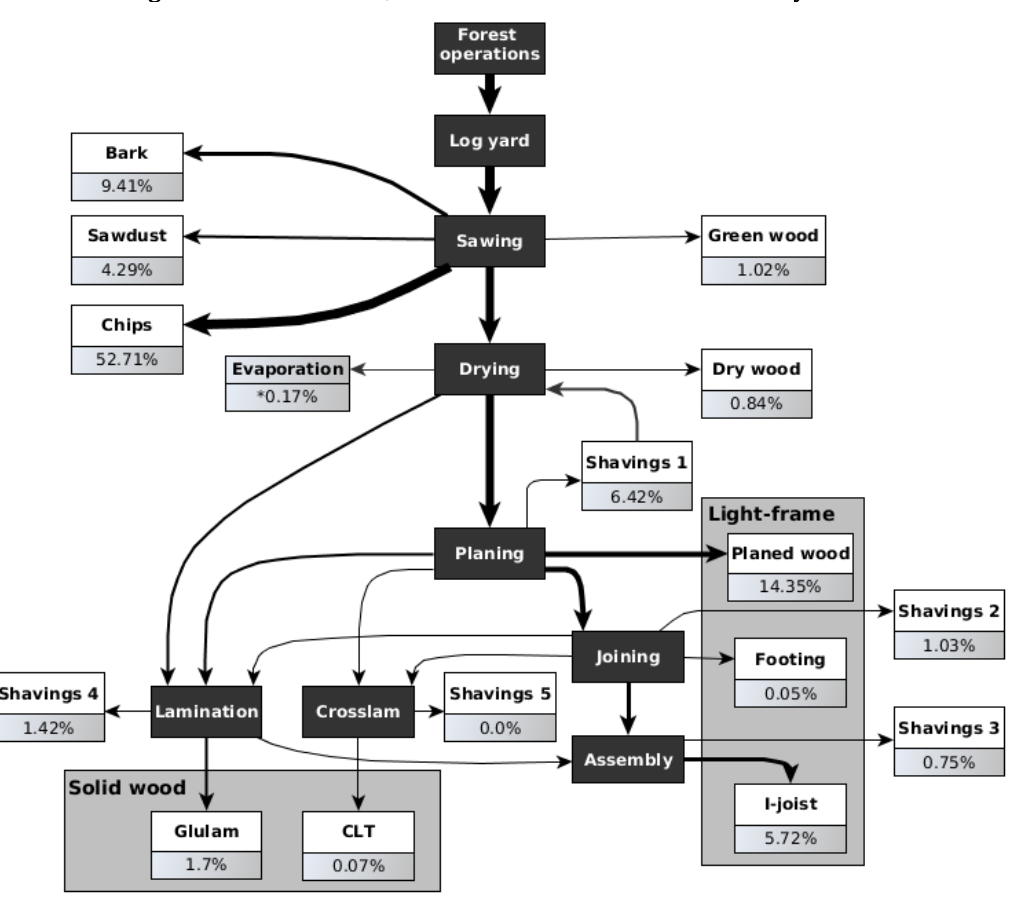
Figure 3: Mass balance, calculated on a cube meter over dry